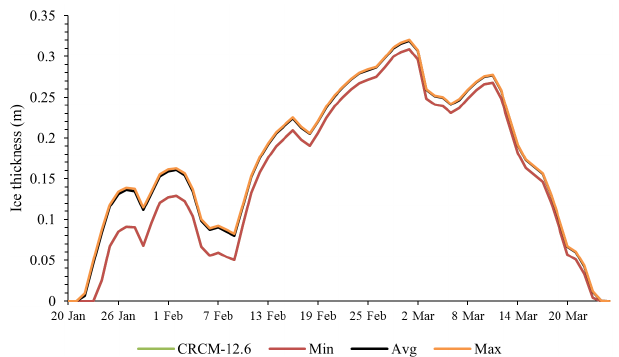
Figure 8. Ice thickness during 2008 for CRCM-12.6 ( K d = 0 . 2m − 1 ) simulation and the lowest (Min, K d = 0 . 58m − 1 ), aver- age (Avg, K d = 0 . 90m − 1 ), and highest (Max, K d = 3 . 54m − 1 ) K d values are shown. CRCM-12.6 and Min (Avg and Max) simulations reproduce similar ice thicknesses, which explains the missing (hid- den) lines of CRCM-12.6 and Max simulations in the plot.